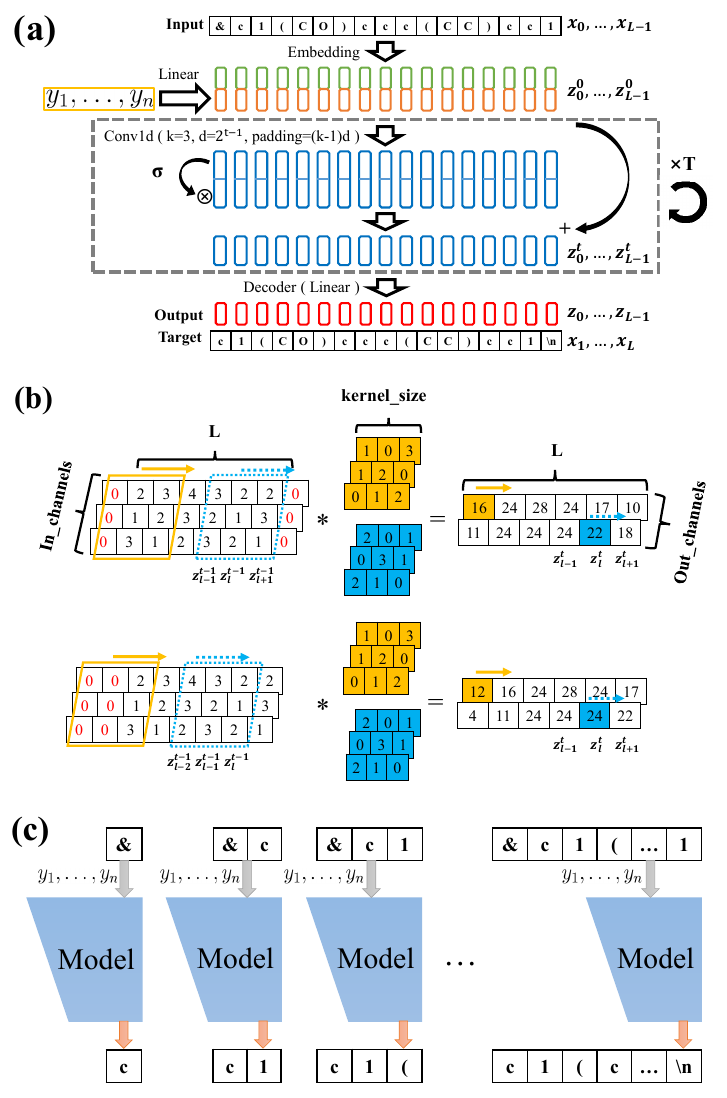
Figure 1. ( a ) The architecture of the generative model. ( b ) The normal one-dimensional multi-channel convolution and causal convolution. ( c ) The conditional generative process of one SMILES string. The CNN allows parallelization over every character in a SMILES string with high efficiency during training. However, each molecular SMILES string should be generated character by character, as shown in Figure 1c. The first character is generated by taking “&” as input and the generative process is terminated as the index of “\n” is met. Between them, the character index j is sampled from the multinomial probability distribution, and the corresponding probability is given